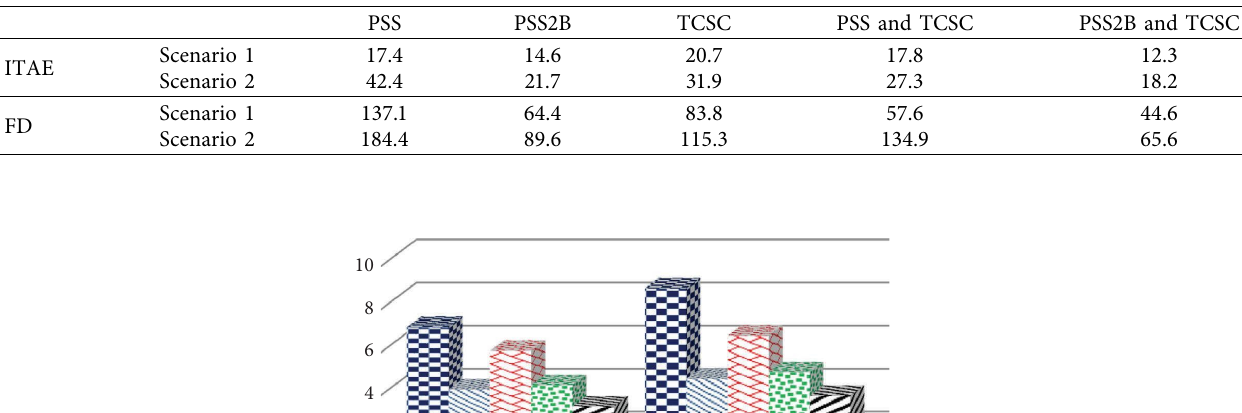
Table 6: Te ITAE and FD values.